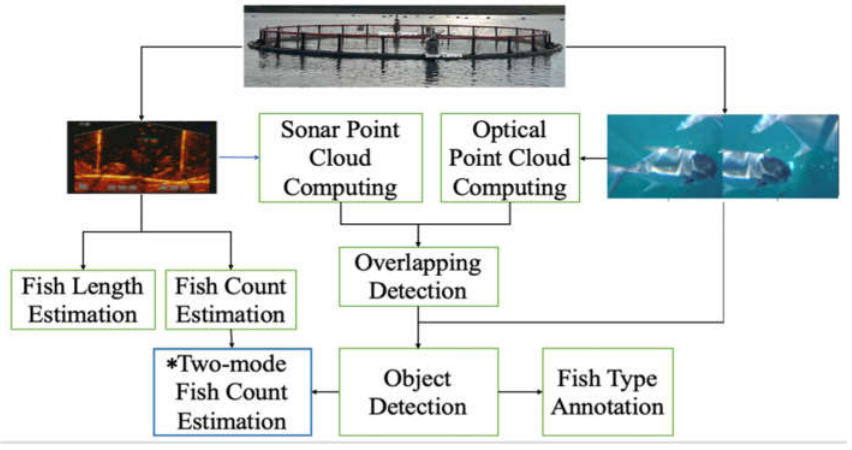
Figure 10. The fish metrics estimation uses sonar and stereo camera fusion and cloud-based AI functions.